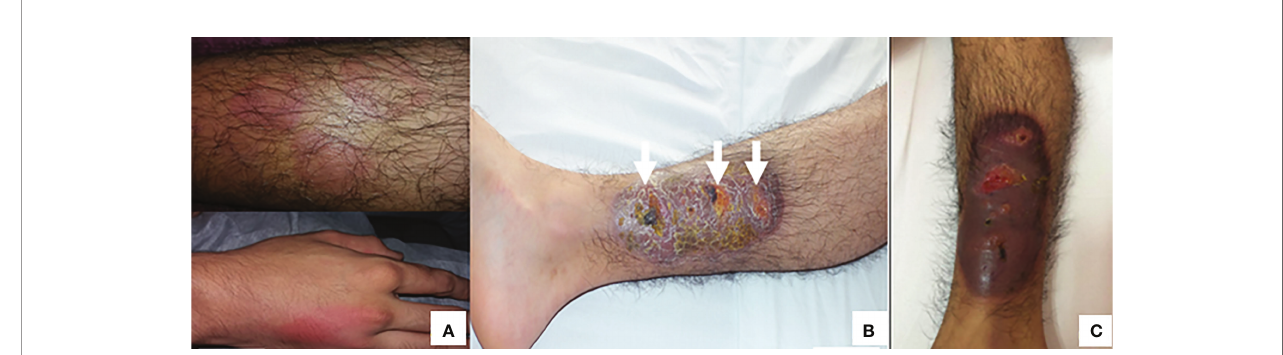
FIGURE 1 | (A) Erythematous macules in hands and legs at the beginning of treatment (July, 2018). (B) The lesion in the right leg progressed to violaceous plaque and necrotic crusts (arrows) (February, 2019). (C) This lesions progressed, despite treatment, to pyoderma gangrenosum-like ulcer